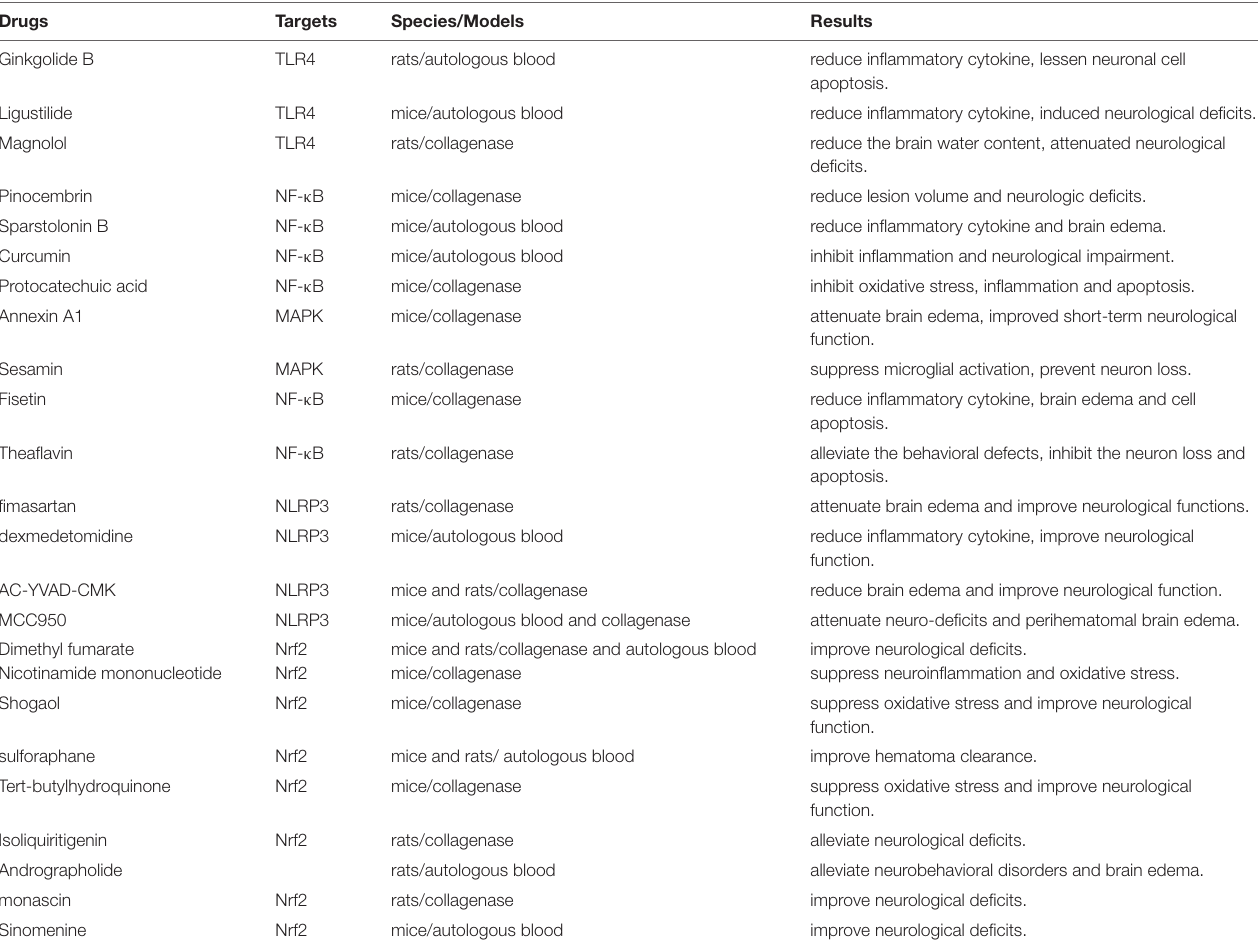
TABLE 3 | Preclinical researches on microglial regulation for ICH therapy.